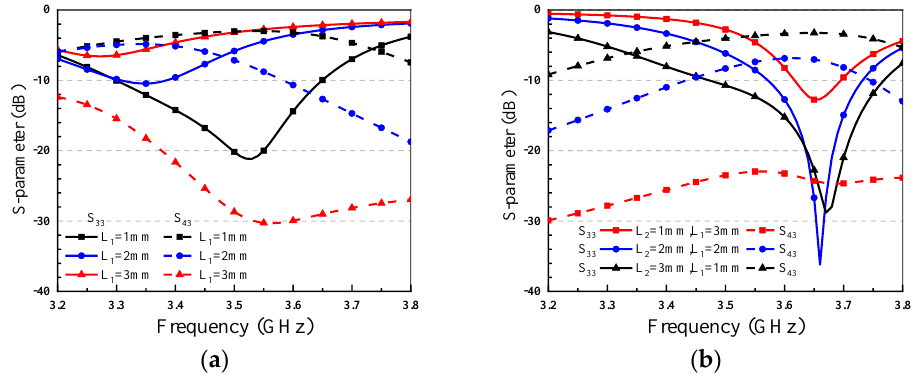
Figure 9. ( a ) Simulated S-parameter of Ant3 and Ant4 with different L 1 . ( b ) Simulated S-parameter of Ant3 and Ant4 with different L 1 and L 2 .